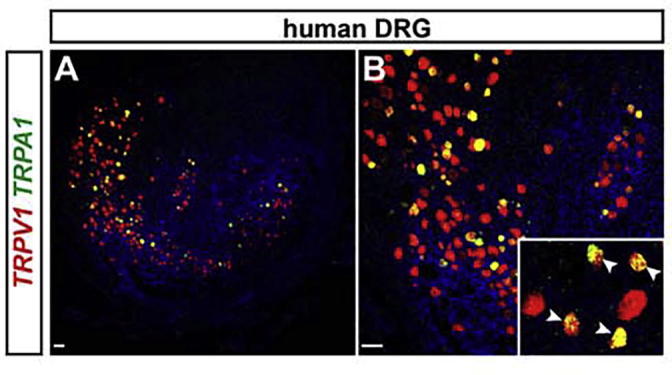
TRPA1 is expressed in a subset of TRPV1 positive neurons in human DRGs. (A, B) Representative dual-color fluorescence in situ hybridization detecting TRPV1 (red) and TRPA1 (green) transcripts in human DRG tissue sections. (A) Overview of a human DRG section and (B) zoom-in of (A). The insert in (B) shows a close-up with arrowheads depicting double-positive cells. Note that all TRPA1 positive cells also express TRPV1. Scale bar = 100 μm.